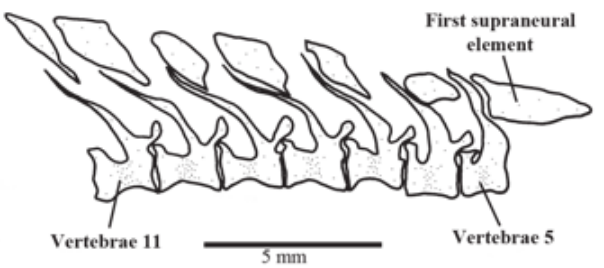
Fig. 2. Right view of vertebrae 5-11 of Parodon orinocensis , MBUCV-V 30116, 99.5 mm